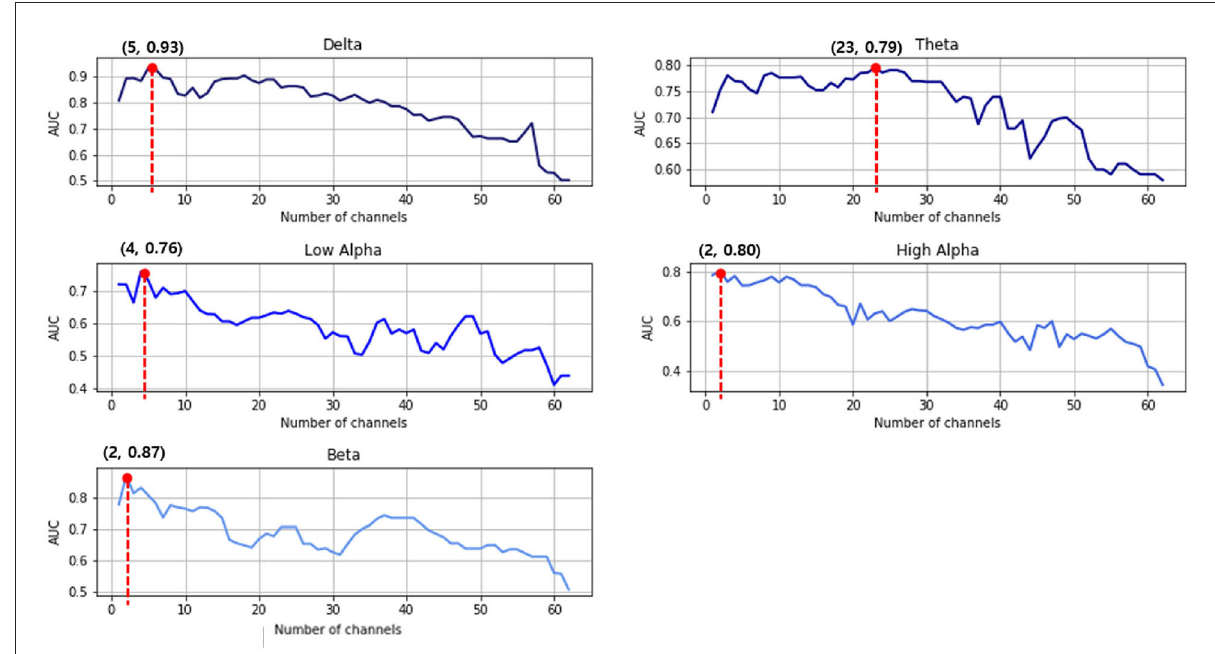
Frequency Single max Multiple max band Balanced Channel AUC Sensitivity Specificity Channel AUC Sensitivity Specificity accuracy (%)